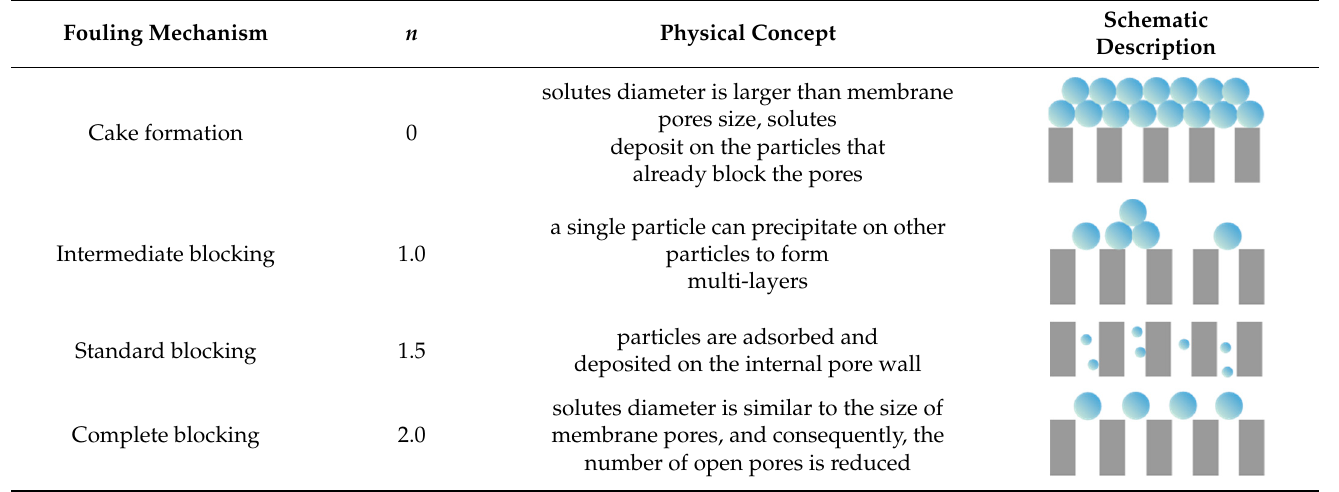
Table 3. Fouling mechanisms based on Hermia’s model.